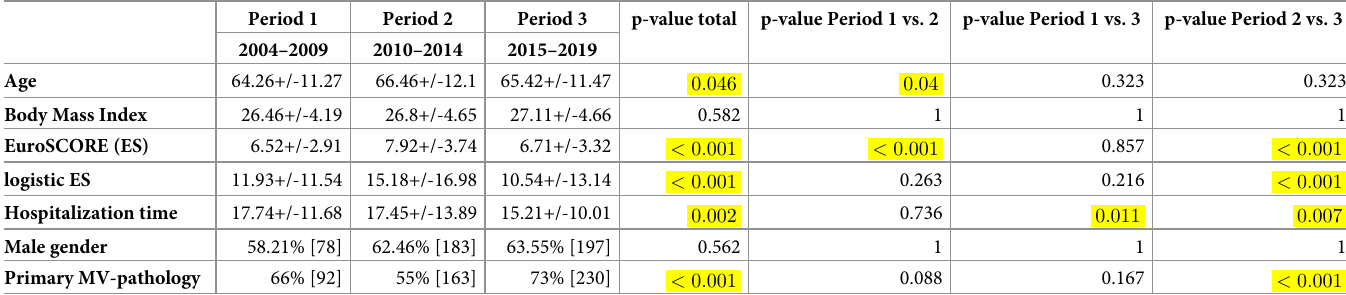
Table 1. Demographic